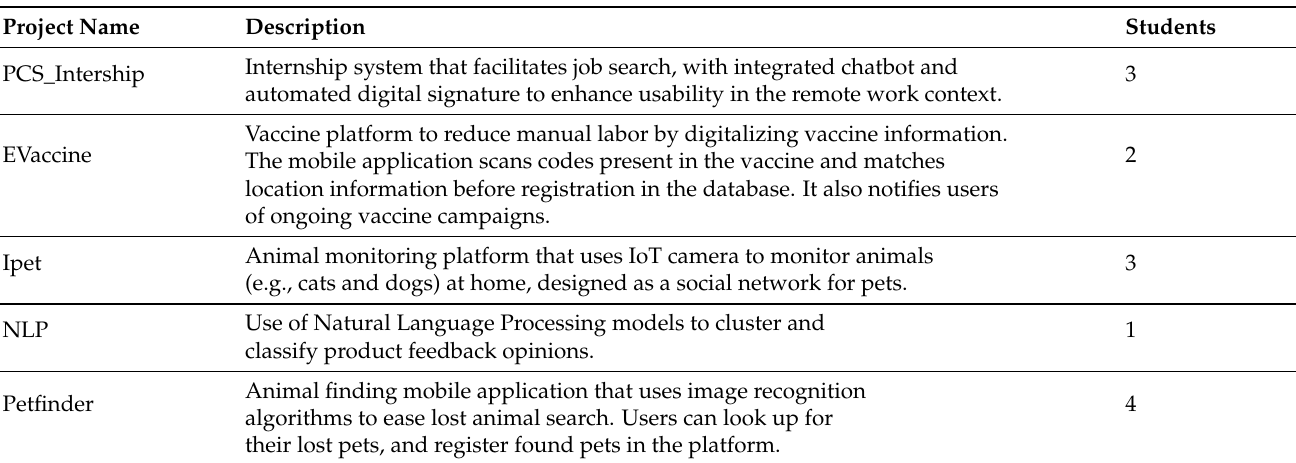
Table 2. Laboratory of Software Engineering II Projects in